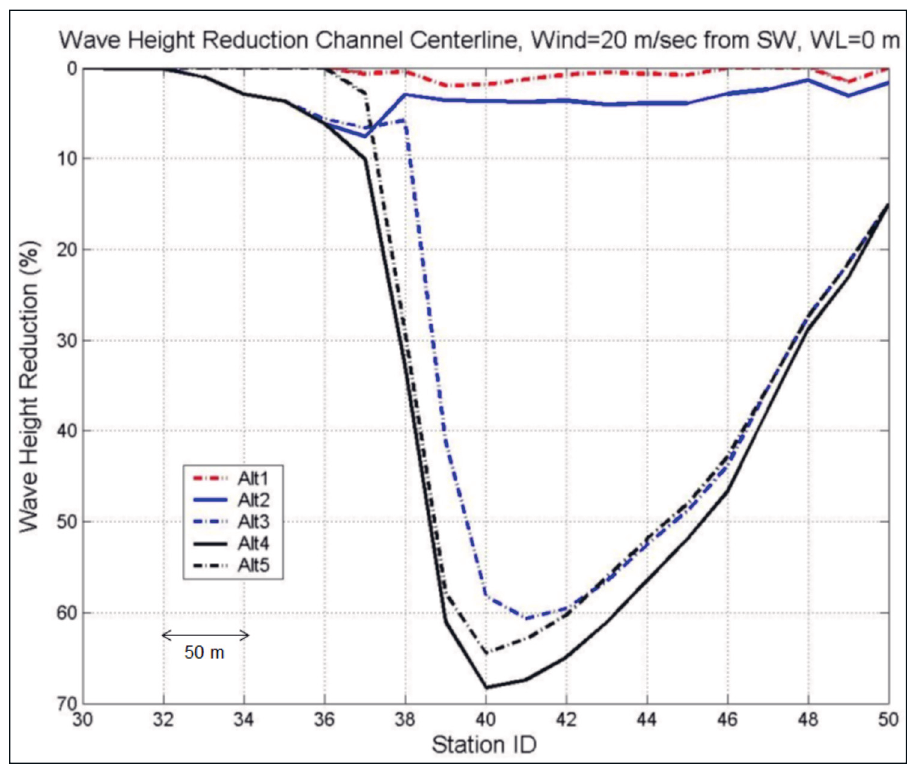
Figure 28. Calculated wave height reduction for Alts 1–5 along the west channel centerline for 50-year design wind from SW and WL = 0